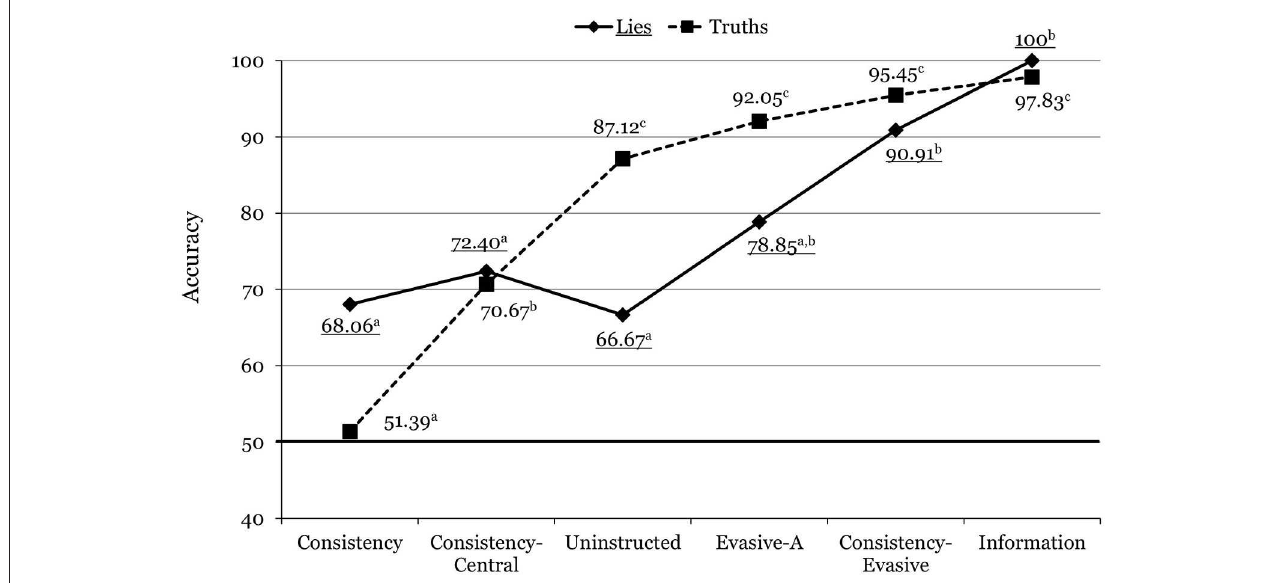
FIGURE 2 | Mean accuracy rates across the different conditions in Experiment 2. For each line, means with different superscripts differ significantly from each other. Underlined values correspond to